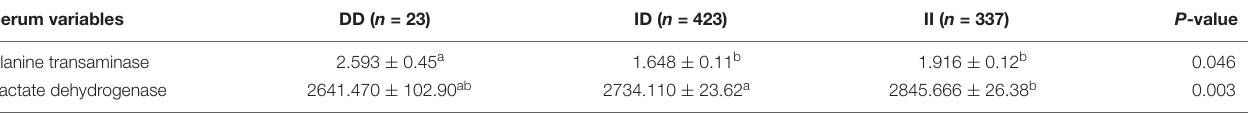
TABLE 5 | Association of the 104-bp locus with serum variables in an F 2 population at 86 days of age. Serum variables DD ( n = 23) ID ( n = 423)